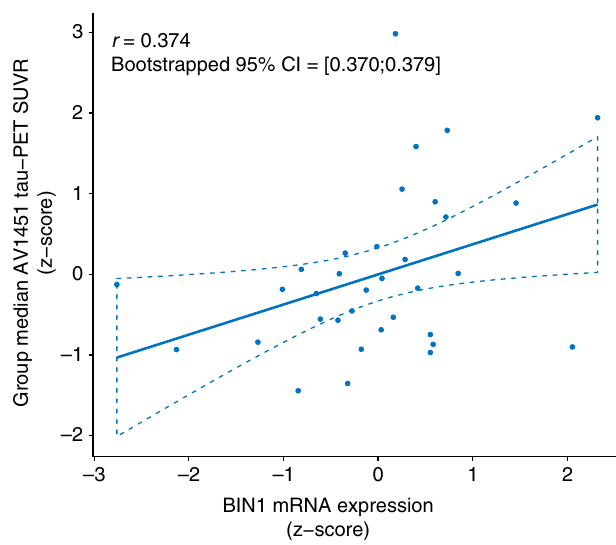
Fig. 5 Association between tau-PET and BIN1 mRNA expression. Scatterplot showing the positive association between ROI-based BIN1 mRNA expression obtained from the Allen Brain Atlas and group-median AV1451 tau-PET uptake (Number of ROIs = 34; Association illustrated as least- squares regression line ±95% con fi dence interval). P- values and 95% con fi dence intervals of r -values are derived from bootstrapped spatial regression with 1000